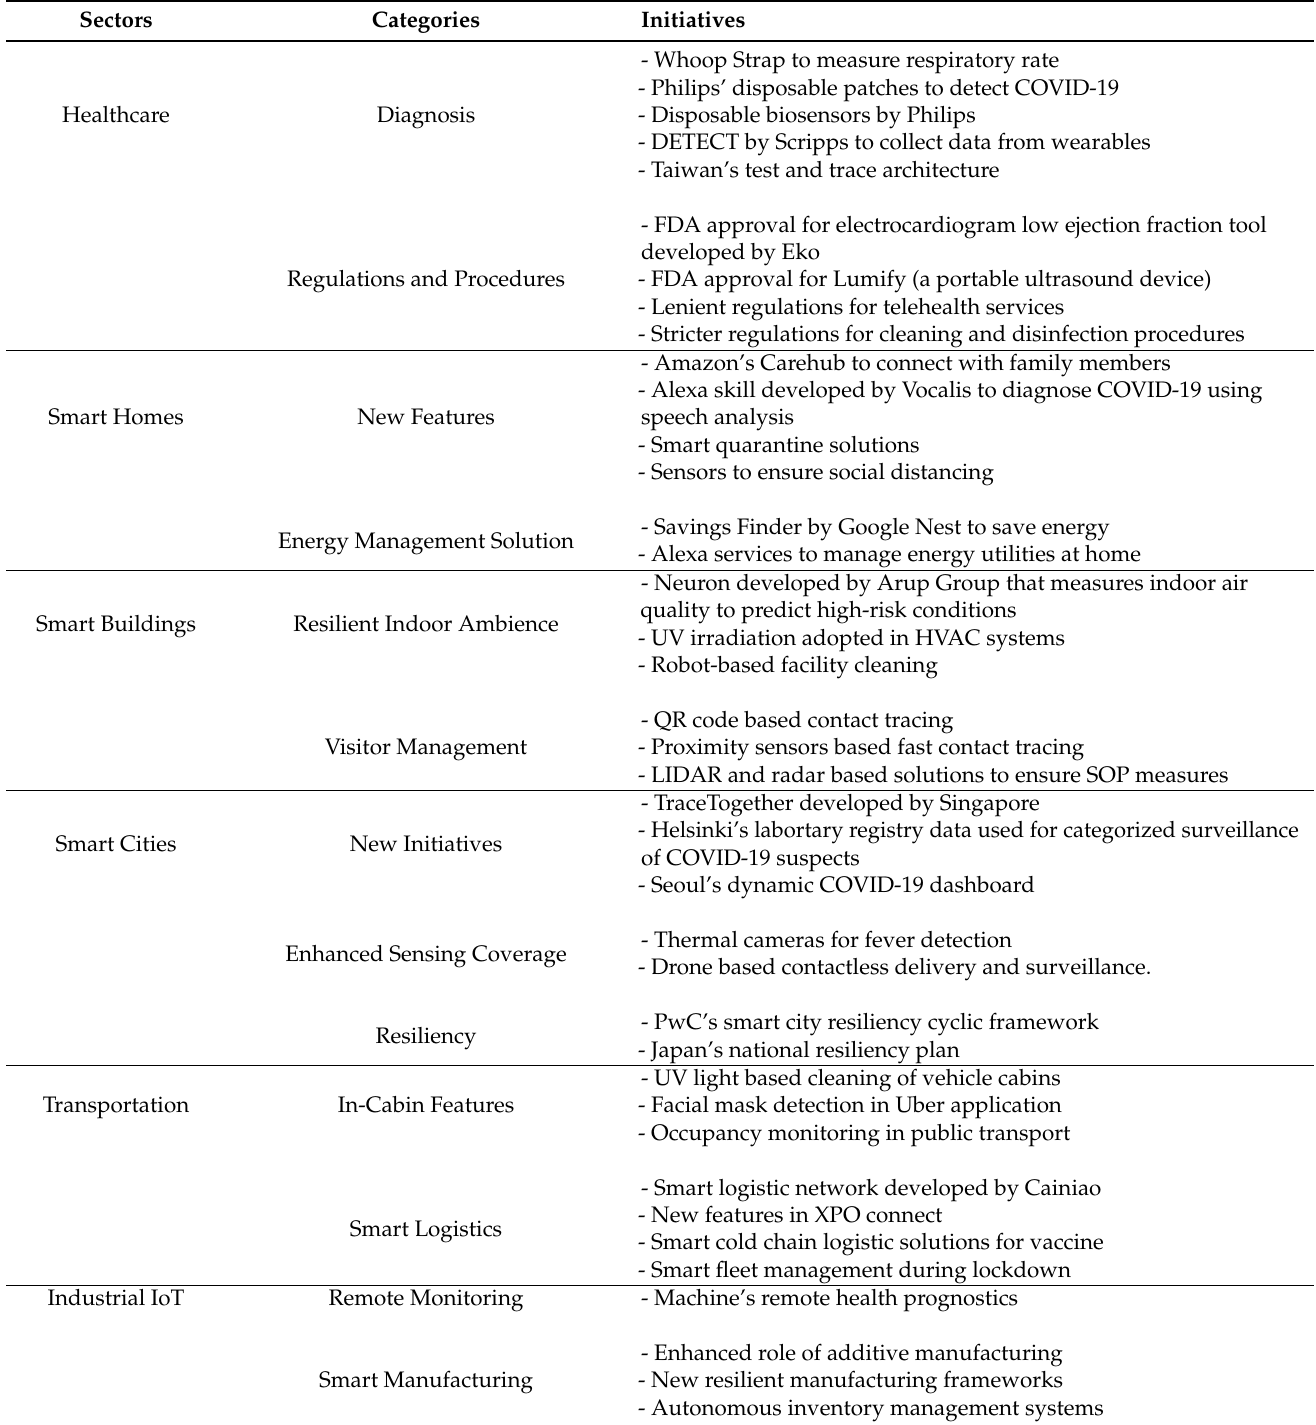
Table 1. Summary of recent initiatives in the wake of